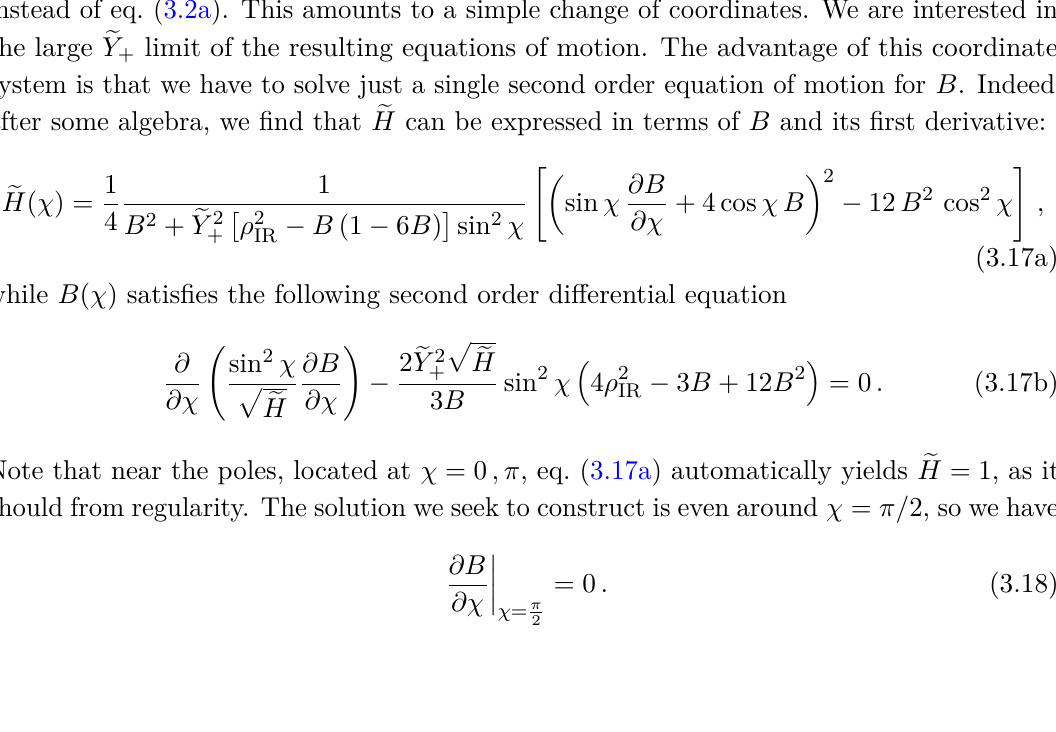
Figure 7 . R ( π/ 2) (blue disks), R (0) (orange squares), F 2 triangles) as a function of Q